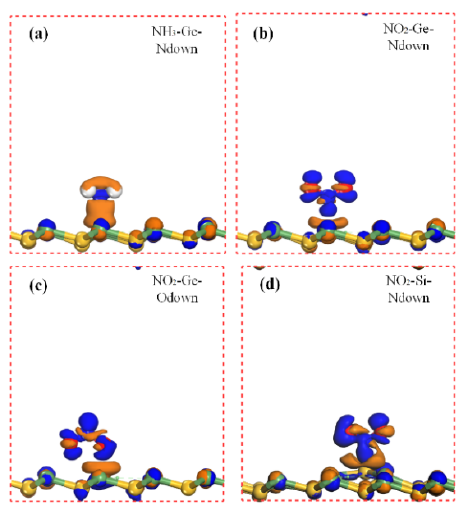
Figure 8. The charge density di ff erence of NH 3 (Figure ( a ) shows NH 3 on Ge site) and NO 2 (Figure ( b ) shows NO 2 on Ge site with N pointed, ( c ) shows NO 2 on Ge site with O pointed, and ( d ) shows NO 2 on Si site) adsorbed on SiGe monolayer.